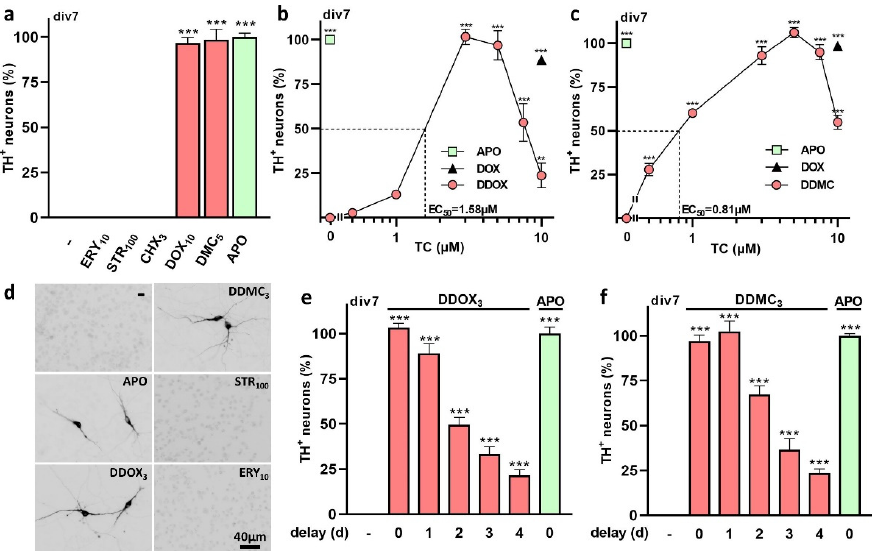
Figure 5. Protection of cultured DA neurons by non-antibiotic TCs. ( a ) Survival of TH + neurons in midbrain cultures chronically treated with ERY (10 µM), STR (100 µM), CHX (3 µM), DOX (10 µM), DMC (5 µM), or APO (100 µg/mL) until div7. Data expressed in % of APO-treated cultures are